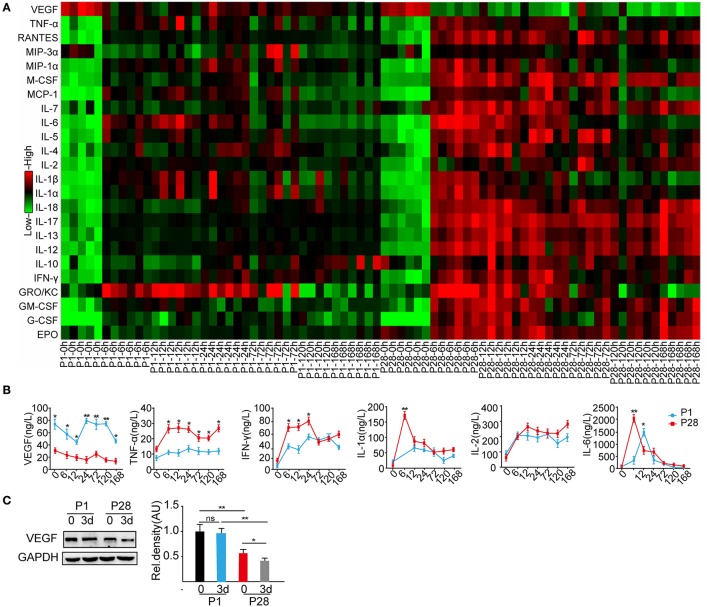
Cytokine profiling of P1 and P28 rats following complete ST. (A) Bio-Plex Pro Rat Cytokine 24-plex Assay Heatmap showed the expression of 24 cytokines in the spinal cords of P1 and P28 rats at different timelines after injury; the color from green to red presents the concentration of cytokines from low to high; (B) Changes in the protein expression of representative cytokines, such as VEGF, TNF-α, IFN-γ, IL-1α, IL-2, and IL-6. VEGF expression significantly changed at every timeline between the two groups (n = 6, *P < 0.05, **P < 0.01). The levels of VEGF, TNF-a, IFN-γ, IL-1a, and IL-6 were significantly higher in P1 ST rats than those in P28 ST rats, but the IL-2 protein level was similar between the two groups (n = 6, *P < 0.05, **P < 0.01); (C) Western blot showed the protein expression of VEGF in the spinal cord of neonatal and adult rats at pre-surgery and 3 days after the surgery. After ST, the VEGF expression was significantly decreased in P28 rats but not in P1 rats compared with the levels before the surgery. Before and after injuries, the VEGF expression was significantly lower in P28 rats than that in P1 rats (n = 6,*P < 0.05, **P < 0.01).